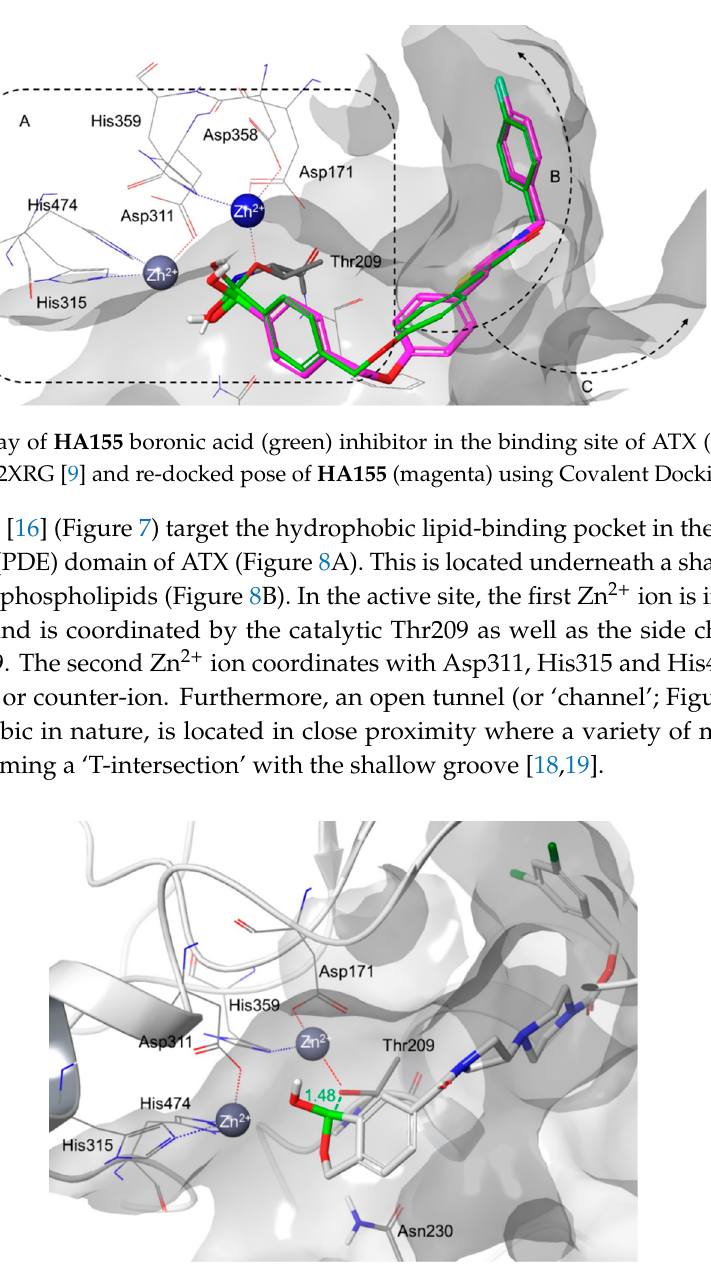
Figure 5. Structures of the warheads (W) and the core spacers (CS).